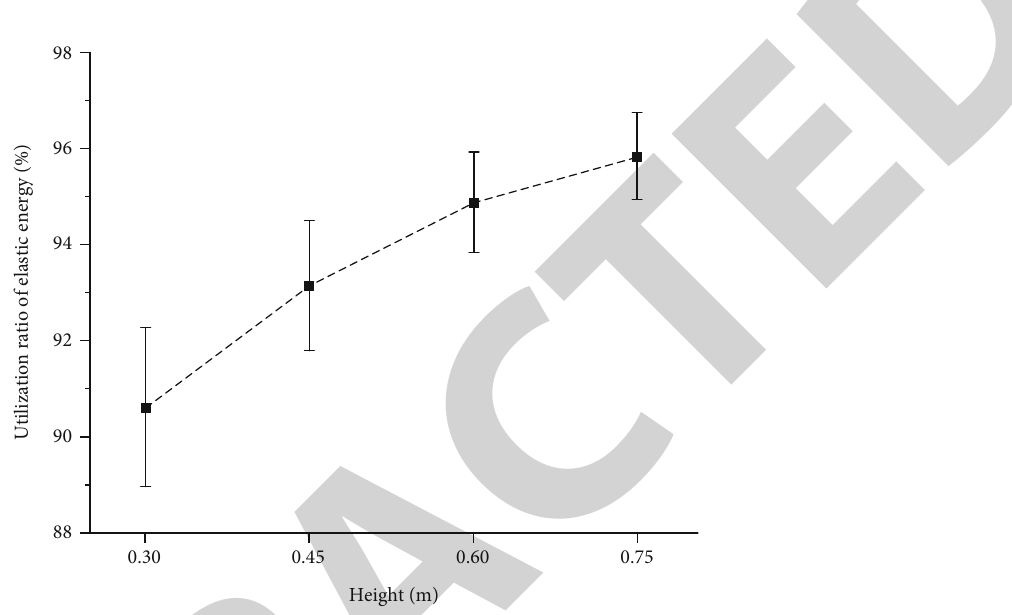
Figure 1: Utilization ratio of low limb elastic energy during drop jump with di ff erent heights. Table 2: The result of Pearson ’ s